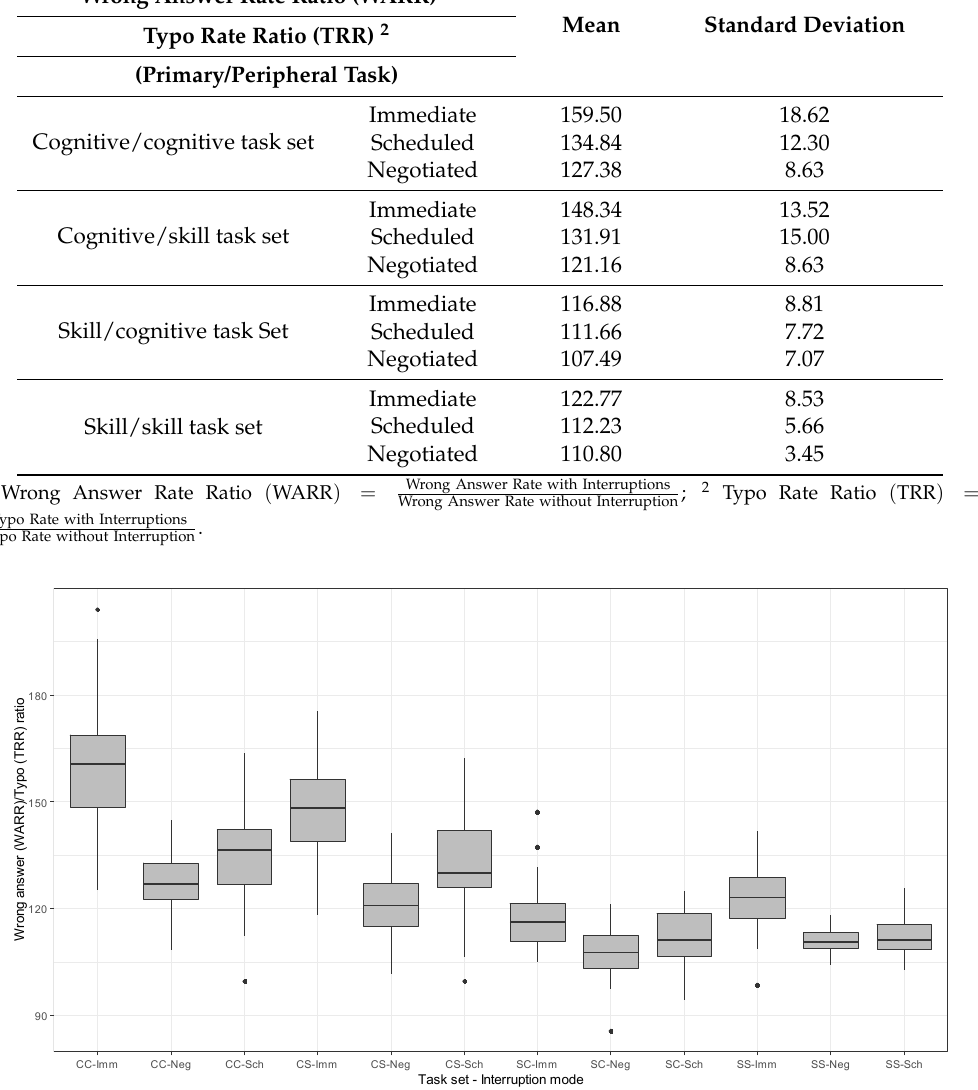
Figure 7. Task accuracy by task set and interruption coordination mode.